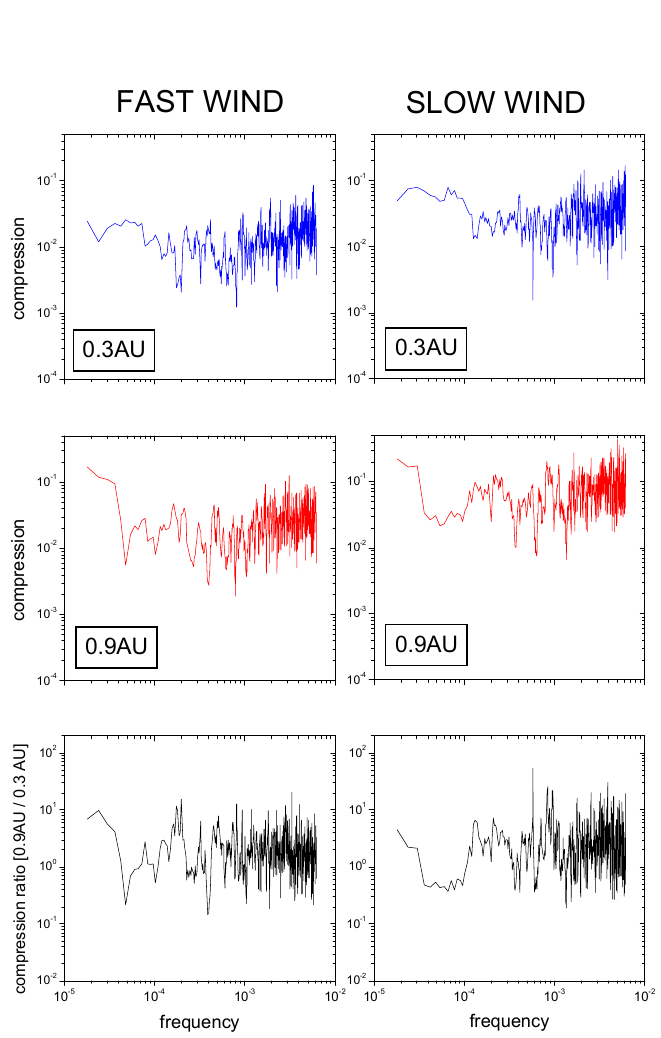
Figure 71: The first two rows show magnetic field compression (see text for definition) for fast (left column) and slow (right column) wind at 0.3 AU (upper row) and 0.9 AU (middle row). The bottom panels show the ratio between compression at 0.9 AU and compression at 0.3 AU. This ratio is generally greater than 1 for both fast and slow